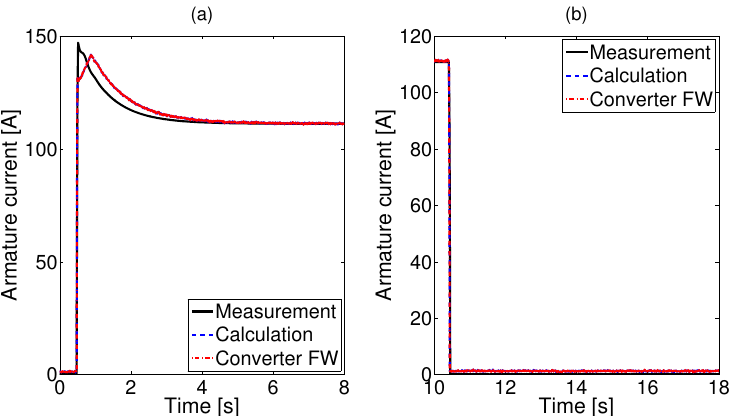
Figure 9. Comparison of the measured, calculated and emulated armature voltage of the synchronous generator during active–reactive load switched on ( a ) and off ( b ).